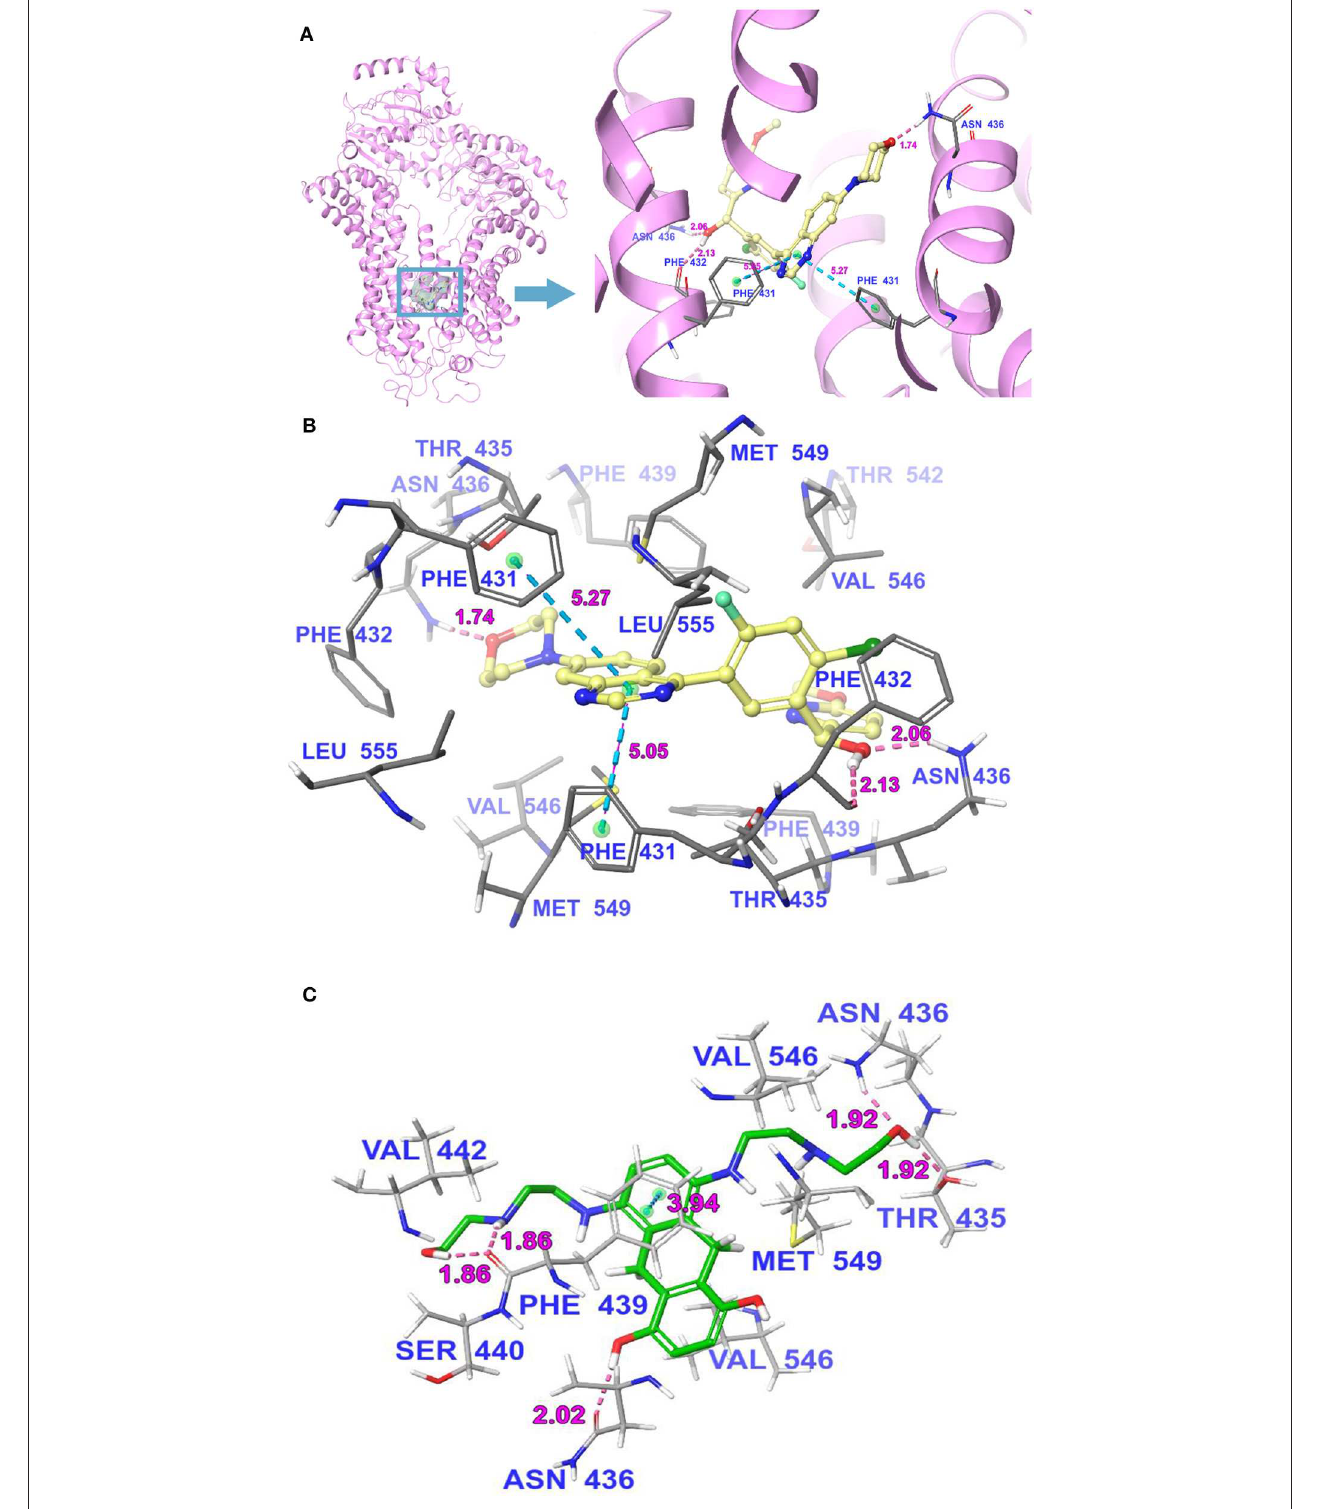
FIGURE 7 | The molecular binding mode of M3814 to the human ABCG2 model as predicted by induced-fit docking. (A) The superimposition of the best-scored pose of M3814 within the binding cavity of ABCG2. Ligand is depicted as a ball-and-stick model with a transparent gray surface and the ABCG2 structure as a ribbon diagram in faded pink. The detailed depiction of M3814 and nearby residues inside the ABCG2 binding cavity are depicted with the atoms colored as follows: carbon,